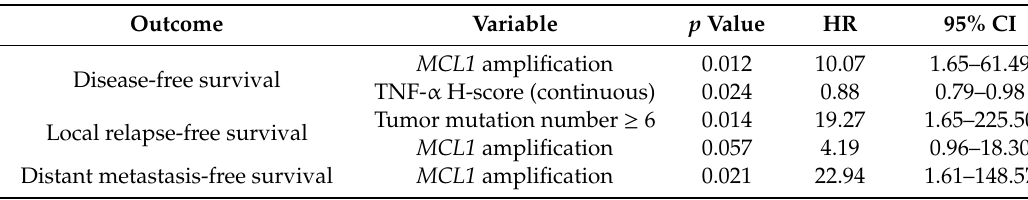
Table 2. Multivariate analysis of disease-free survival (DFS), local relapse-free survival (LRFS), and distant metastasis-free survival (DMFS).